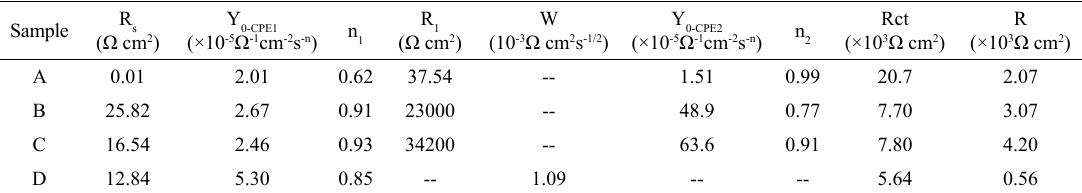
Table 3 lists the fitting parameters based on the equivalent Table 3. Equivalent circuit parameters for EIS results of different coatings